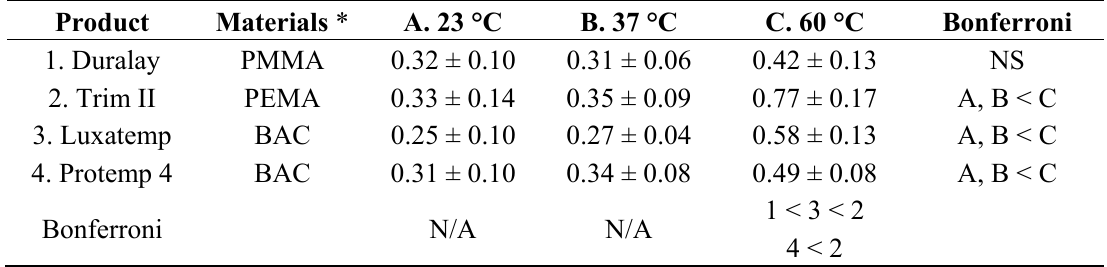
Table 5. Marginal discrepancy (mm) (±SD) of materials and curing